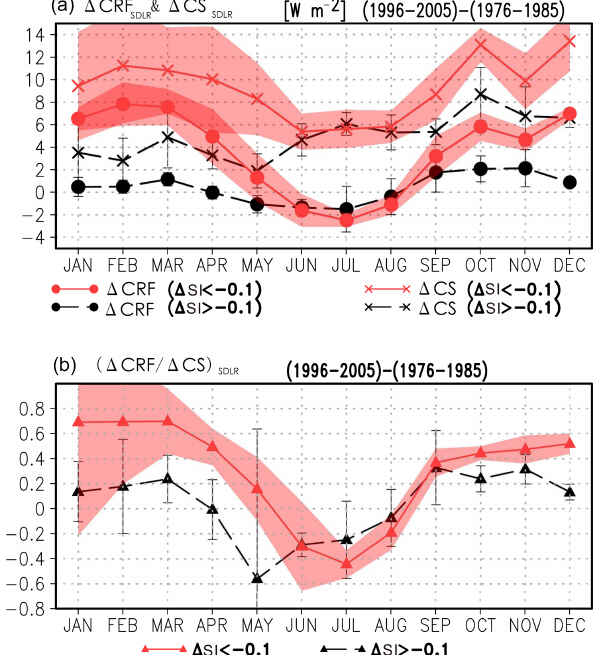
Figure 9. Annual time series of (a) the change in (crosses) the CRF in surface DLR ( (cid:49) CRF SDLR ) and (closed circles) clear-sky surface DLR ( (cid:49) CS SDLR ) between the averages for 1976–1985 and 1996–2005 in the MIROC5 simulations and (b) the index (( (cid:49) CRF /(cid:49) CS) SDLR , the ratio of (cid:49) CRF SDLR to (cid:49) CS SDLR ) . The solid red (broken black) lines indicate the (cid:49) SI − ( (cid:49) SI + ) case. See the text for the definition of the index. Shading and error bars indi- cate the standard deviations for the ensemble members in the (cid:49) SI − and (cid:49) SI + cases, respectively.